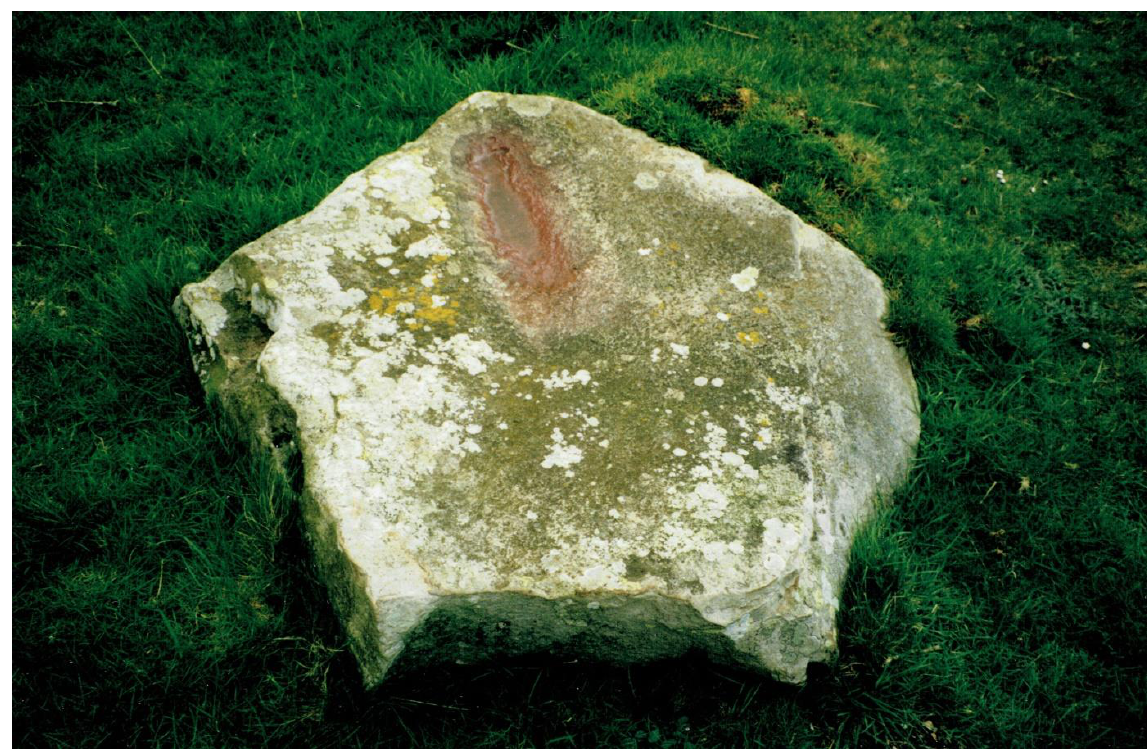
Figure 23. This shaped stone with medially pecked groove is on the hills east of Avebury. It marks the false crest near the Ridgeway where the sun rises at Beltane as seen by watchers at the South Circle. (Author’s